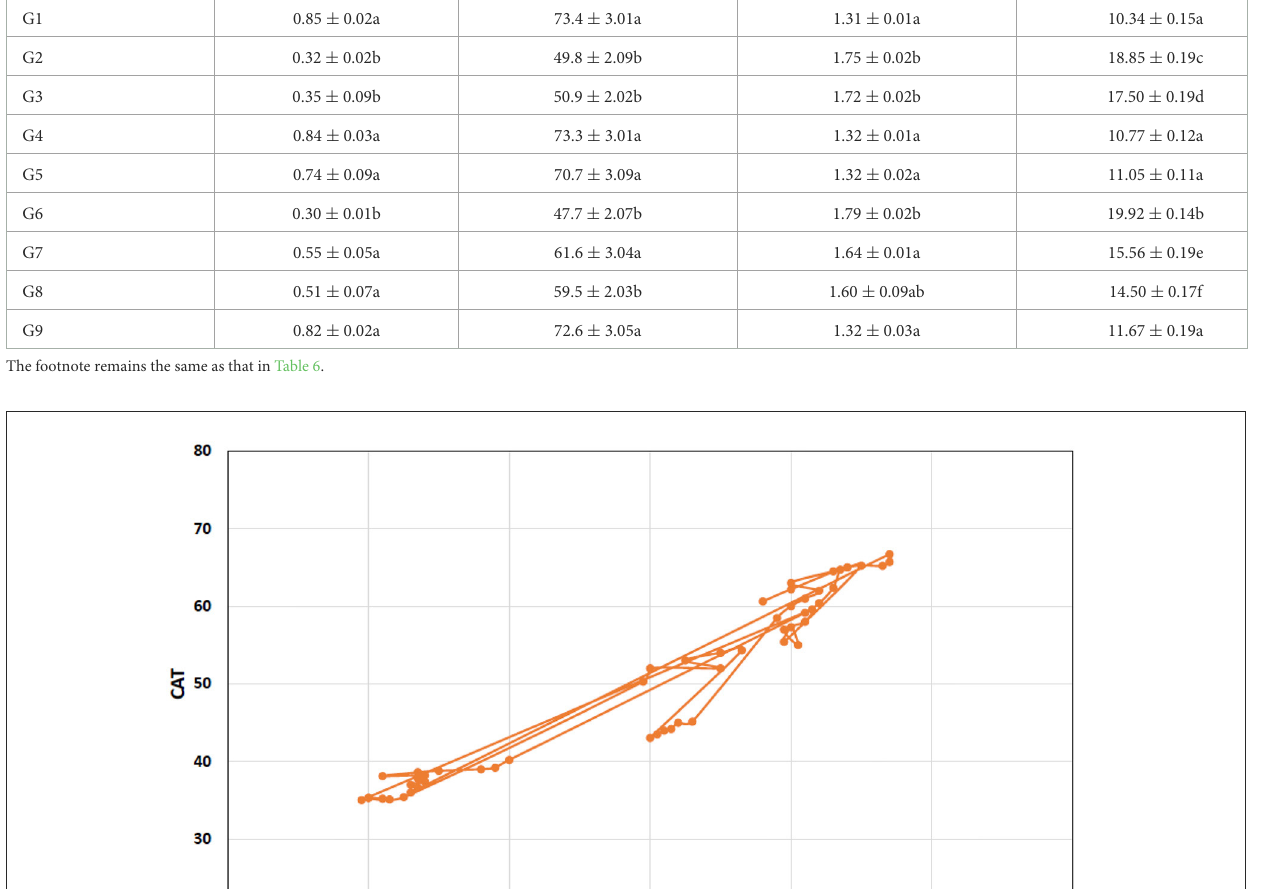
TABLE 7 Antioxidant enzymes/parameters (TAC and CAT) and oxidant enzymes (TOC and MDA) in broiler chicks on day 42 experiment administered arsenic, chromium, vitamin E, and bentonite alone or in combinations. Groups